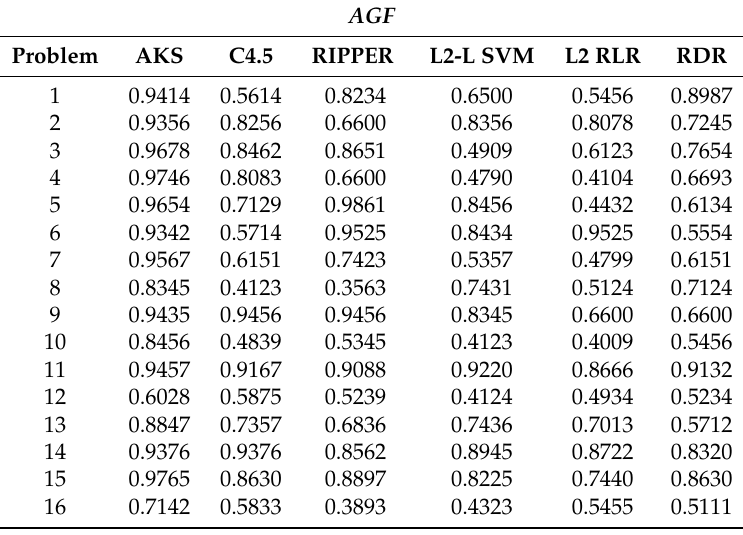
Figure 7. Parameter Choice 2. The x and y axes represent the values of the parameters of the two methods, while on the z axis is plotted the AGF for two of the OvA configurations on the dataset in [4]: ( a ) Class 4 vs. all and ( b ) Class 19 vs. all. The gray and blue surfaces represent, respectively, the results with the AKS and SVM classifiers. Table 16. Comparison results on the dataset in [26] and Table 14. RDR, Ripple-Down Rule